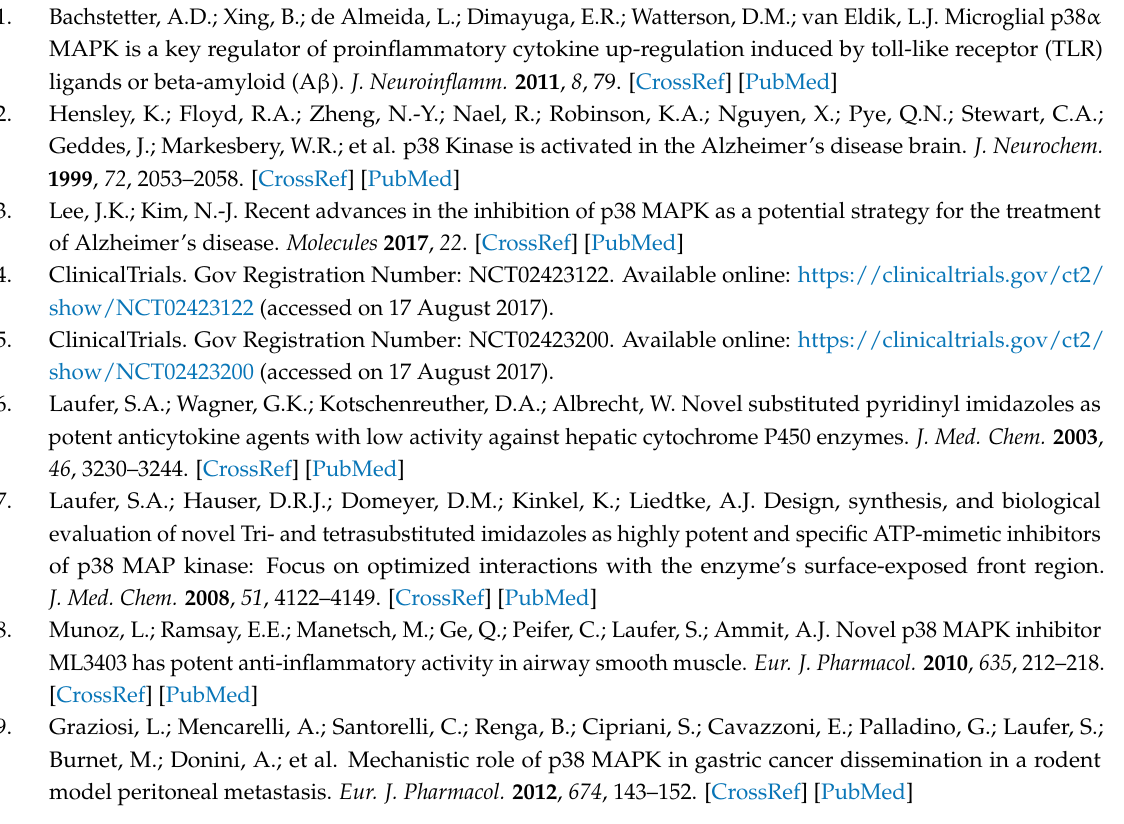
Supplementary Materials: The following are available online, Figure S1 (Structure of VX-745 ) and Tables S1–S17 (metabolic stability of the title compounds in HLM and metabolite